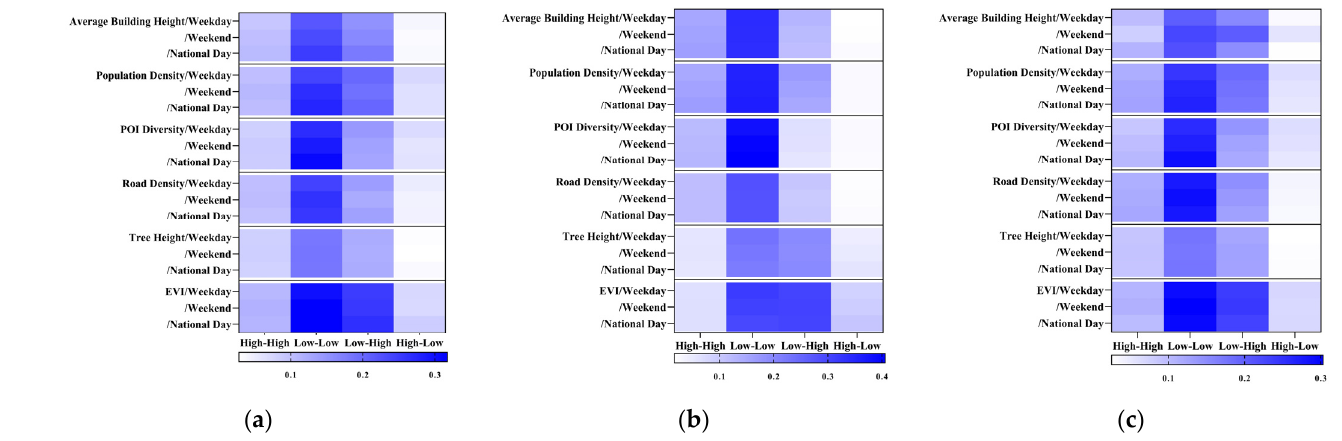
Figure 6. The statistical heat map of the BiLISA results. ( a ) Statistical heat map of the BiLISA results for Group 1. ( b ) Statistical heat map of the BiLISA results for Group 2. ( c ) Statistical heat map of the BiLISA results for Group 3.